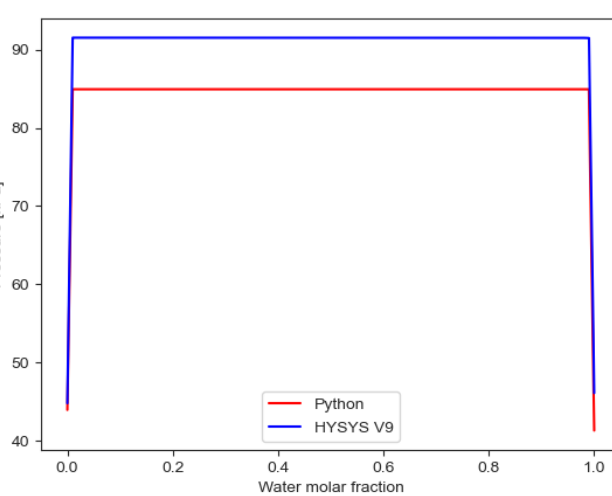
Figure 5. Comparison of VLLE results for water/PASN using Python and HYSYS V9 (no air).